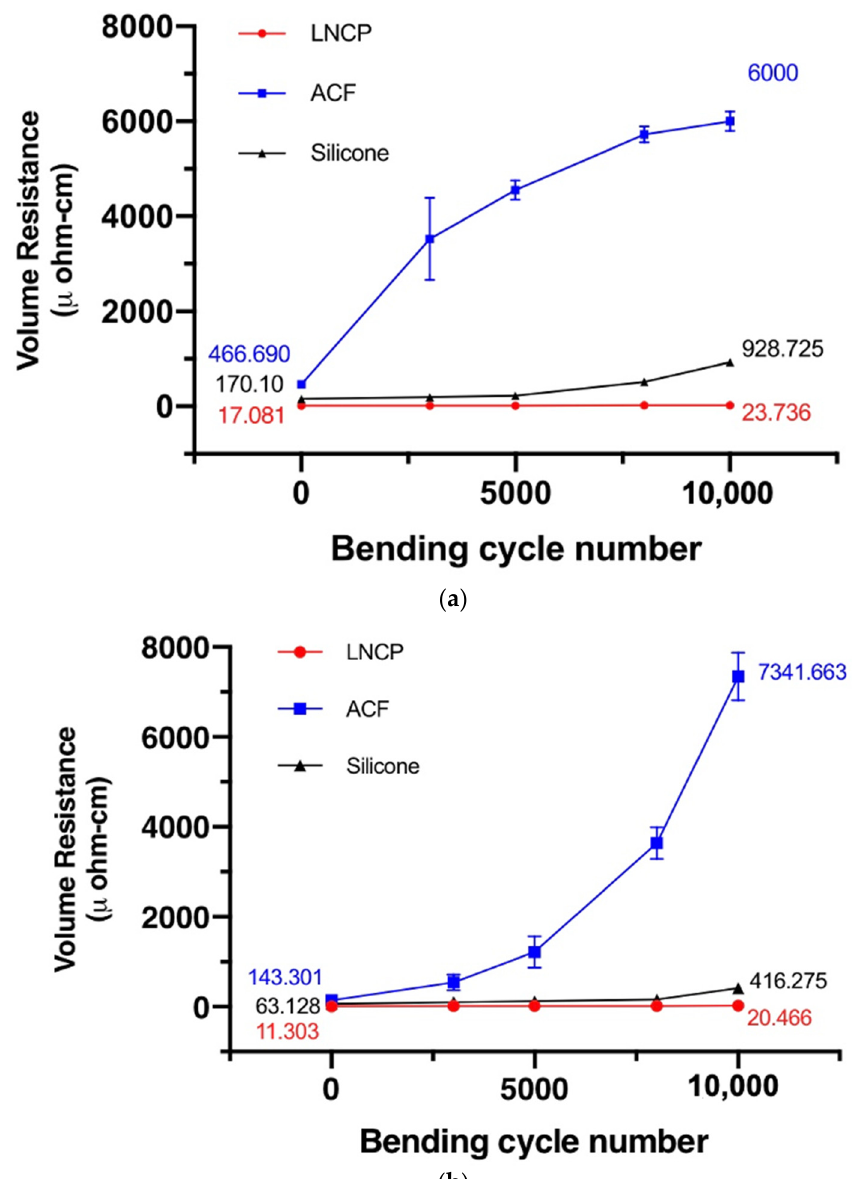
Figure 11. The relationship between the number of bends for test pieces and their respective electrical resistivity: ( a ) PI/Cu, and ( b ) PI/Cu/Ag.